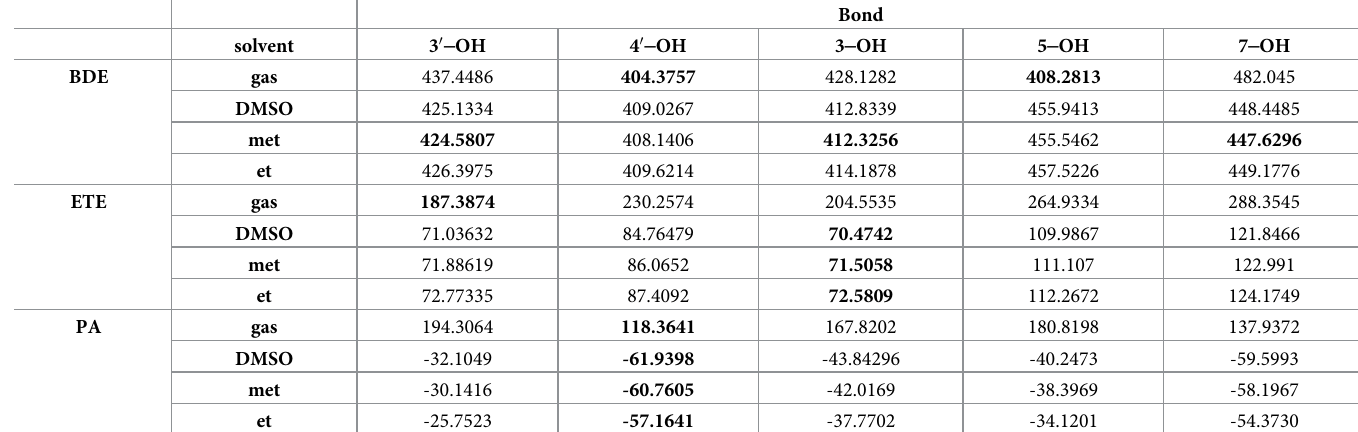
Table 5. ETE, BDE and PAvalues in kj/mol obtained at DFT/M06-2X/6-311++Gdp level of